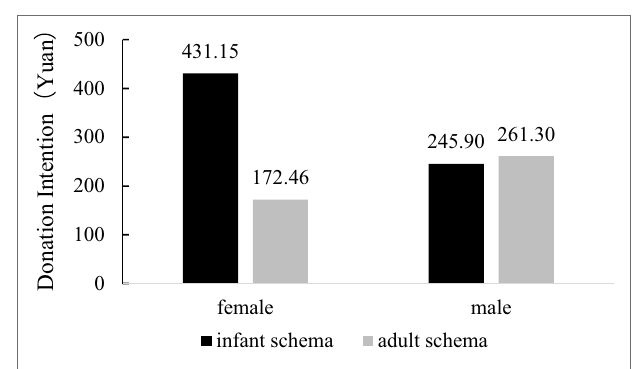
FIGURE 4 | Influence of infant schema cues on female and male donation